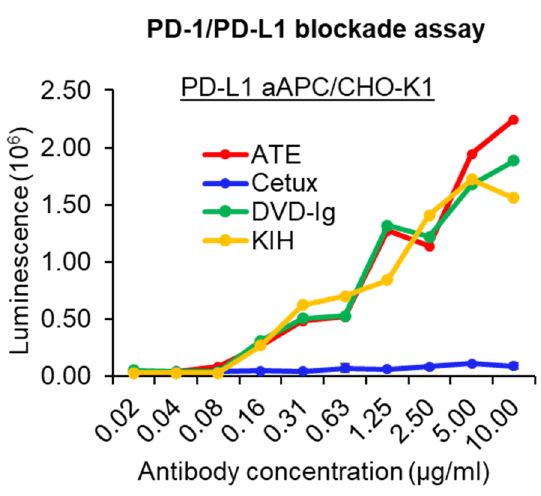
Figure 4 . PD-1/PD-L1-blocking activity of anti-EGFR/PD-L1 BsAbs was determined by PD-1/PD-L1 blockade cell-based assay (Promega) to assess the ability of the anti-EGFR/PD-L1 BsAbs to block PD-1/PD-L1 engagement compared to parental mAbs. This experiment has been performed in bio- biological triplicates, and data are representative of two or more independent logical triplicates, and data are representative of two or more independent experiments.